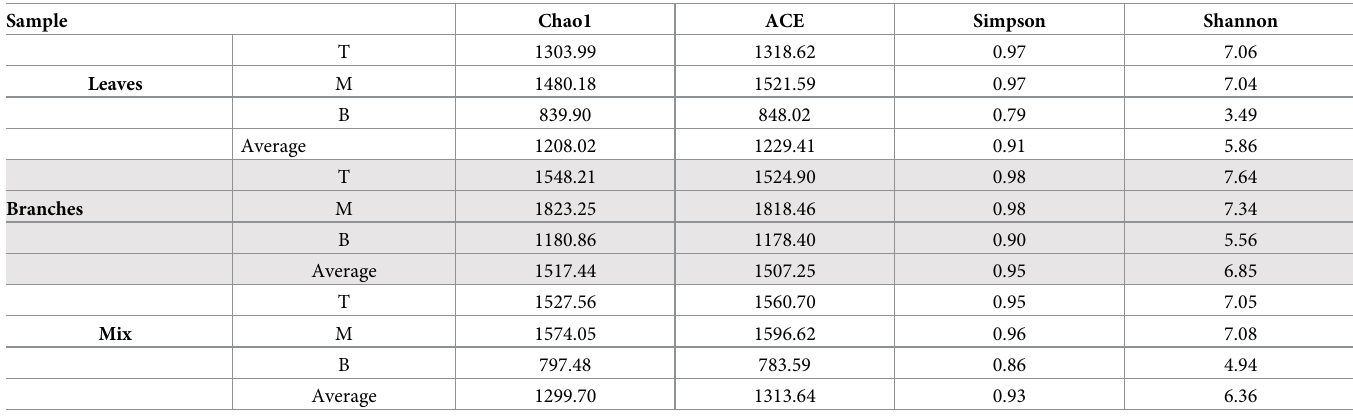
Table 2. Bacterial diversity indexes at different decomposition stages of fungus-combs.